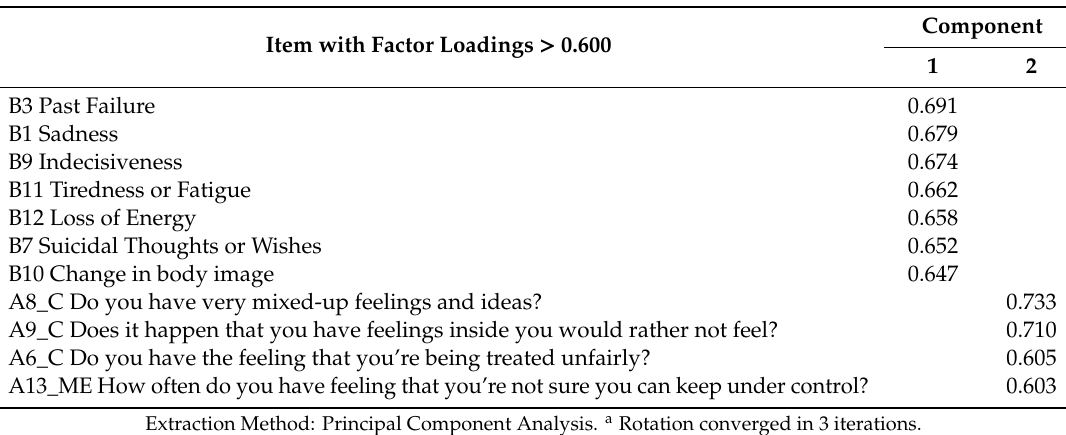
Table 5. Rotated component matrix a .